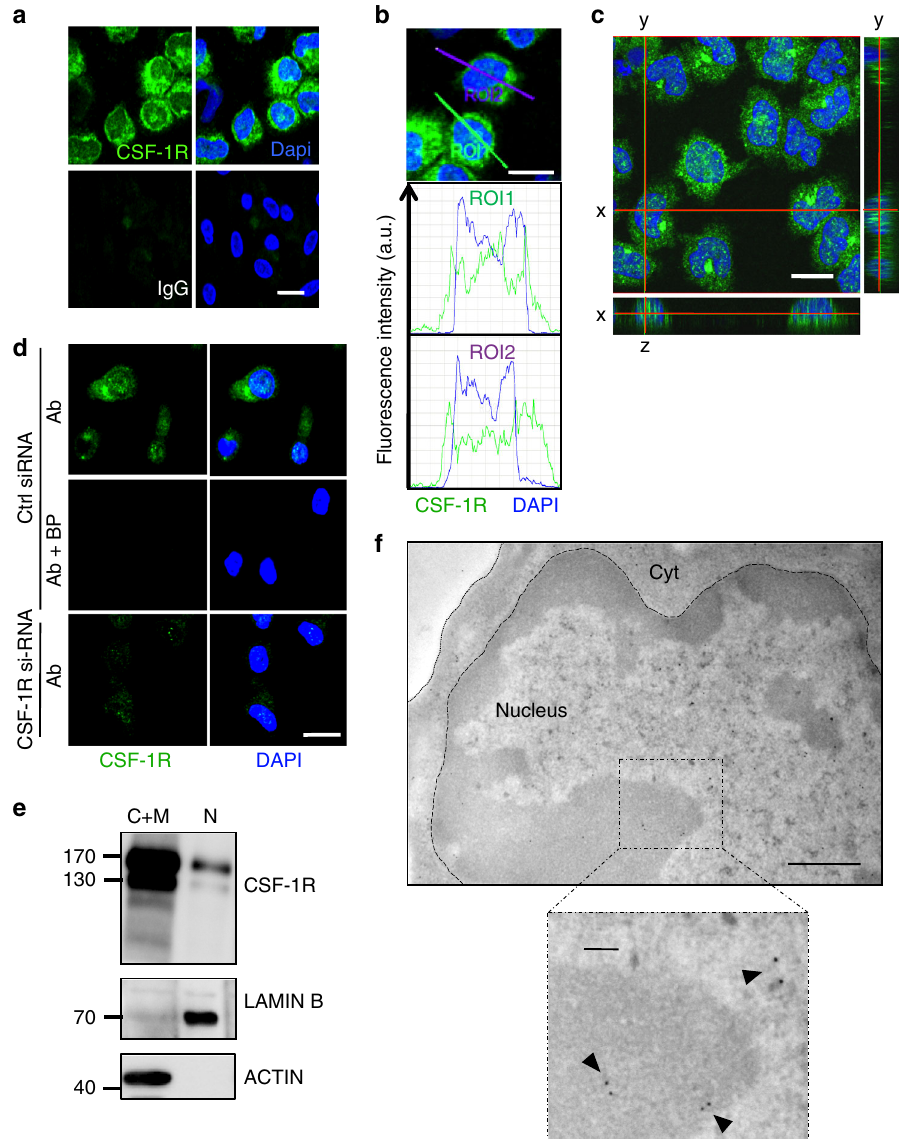
Fig. 1 A fraction of CSF-1R is located in the nucleus of human monocytes. a Sorted peripheral blood human monocytes were stained with an anti-CSF-1R antibody (Cter sc-692) or a control IgG (green) and Dapi (blue), followed by confocal imaging analysis ( n = 3, scale: 10 μ m). b Quanti fi cation of the signal generated by CSF-1R labeling (green) and Dapi (blue) according to indicated axes (A.U.: arbitrary units, ROI: region of interest, scale: 10 μ m). c Monocytes were stained with an anti-CSF-1R antibody (Cter sc-692) and Dapi (blue), followed by confocal imaging analysis (stack of 50 pictures of 0.2 μ m) to reconstitute an orthogonal view (scale: 10 μ m). d The speci fi city of CSF-1R labeling with sc-692 antibody (Ab in green) was explored in monocytes transfected 24h before with a CSF-1R speci fi c or a control si-RNA and treated or not with sc-692 blocking peptide (BP, n = 2, scale: 10 μ m, Dapi in blue). e Monocytes were fractionated into cytoplasmic plus membrane (C + M) and nuclear (N) fractions and analyzed by immunoblotting with antibodies that recognize CSF-1R (Cell signaling #3152), Lamin B (N fraction) and actin (C + M fraction) ( n = 3). f Immunogold analysis of CSF-1R expression in monocytes using the anti-Cter sc-692 antibody and electron microscopy ( n = 2, scale: 500 nm; insert: 100